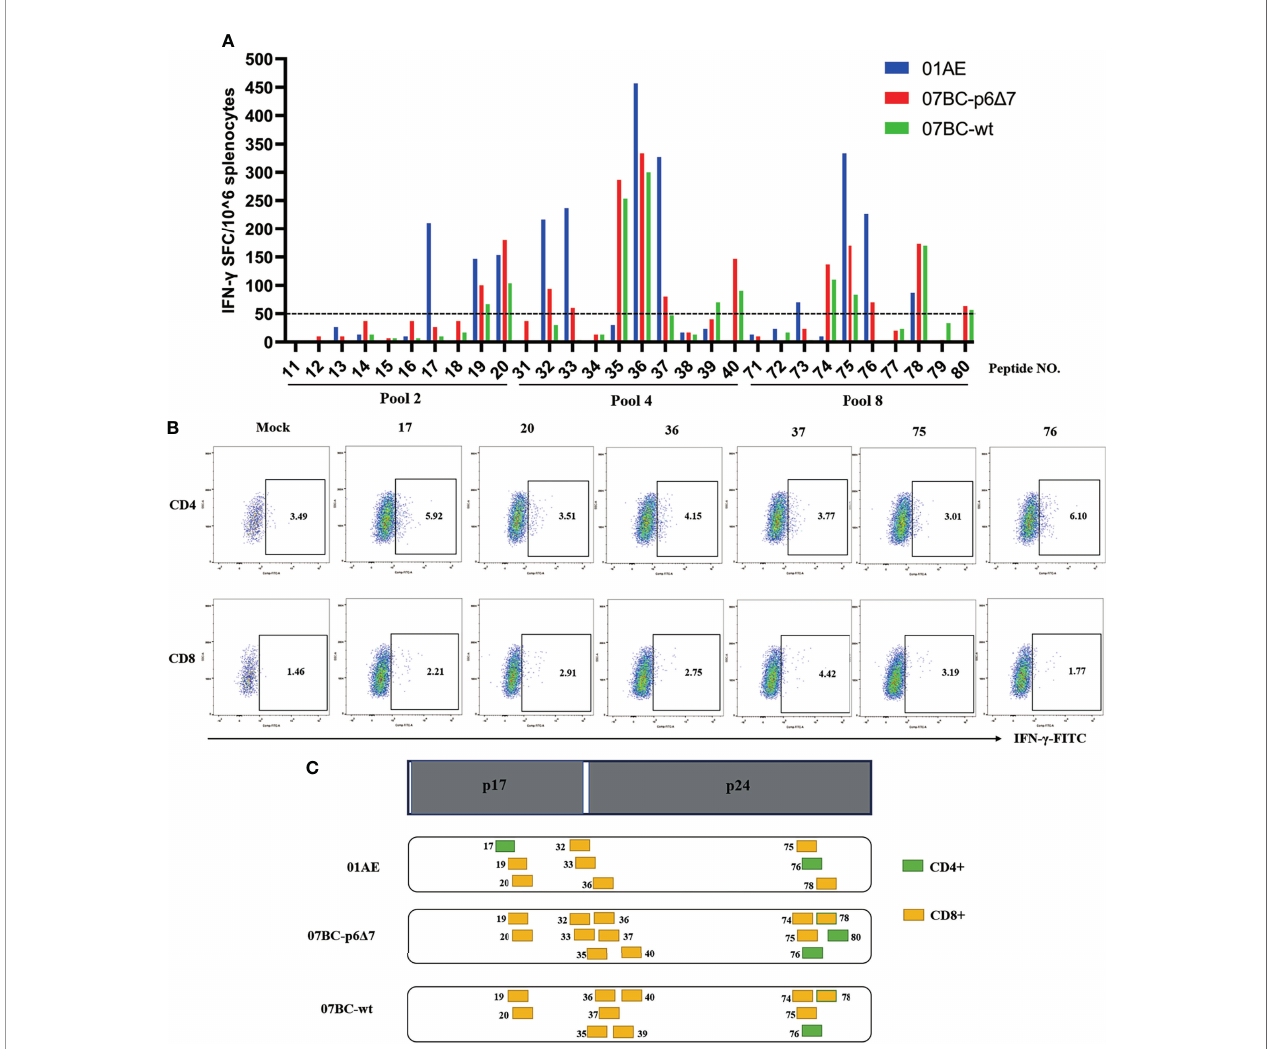
FIGURE 3 | Speci fi c T-cell responses induced by Ad2-based vaccine and identi fi cation of the T-cell epitope. After Ad2 boost vaccination, mice were sacri fi ced, and the splenocytes from mice were restimulated ex vivo with peptide pools. The background-subtracted median responses (n = 5) in BALB/c mice following vaccination are shown. (A) Mouse splenic lymphocytes isolated after boost vaccination were stimulated with individual overlapping 15-mer peptides (pool 2, pool 4, and pool 8) in IFN- g ELISpot assay. The dotted line represents the cutoff value. (B) Peptides that successfully induced responses above cutoff values in IFN- g ELISpot assays were then tested for their ability to induce IFN- g production in T cells by intracellular cytokine staining (ICS) assays. (C) Epitope mapping analysis of the CD8 + and CD4 + T-cell epitopes is represented by orange and green boxes,